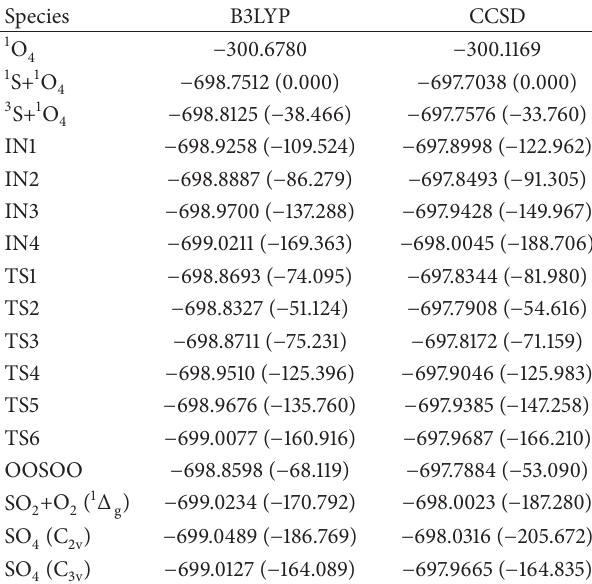
Table 1: The total energies (in Hartree) and relative energies (in parentheses and kcal/mol) of the reactants, products, and interme- reaction on the singlet diates in the 1 S+ 1 O 4